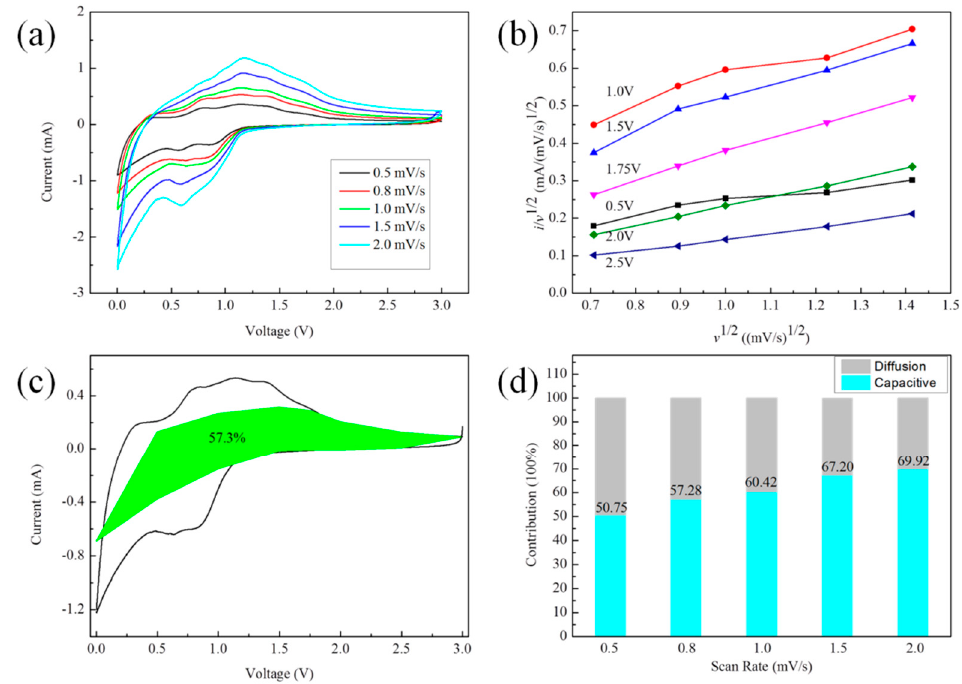
Figure 5. Quantitative capacitive analysis of sodium storage behavior of SnS/NG. ( a ) Cyclic voltammetry (CV) curves at different scan rates. ( b ) Plots of v 1/2 vs. i / ν 1/2 . ( c ) Capacitive contribution at 0.8 mV/s. ( d ) Normalized contribution ratio of capacitive capacities at different scan rates.